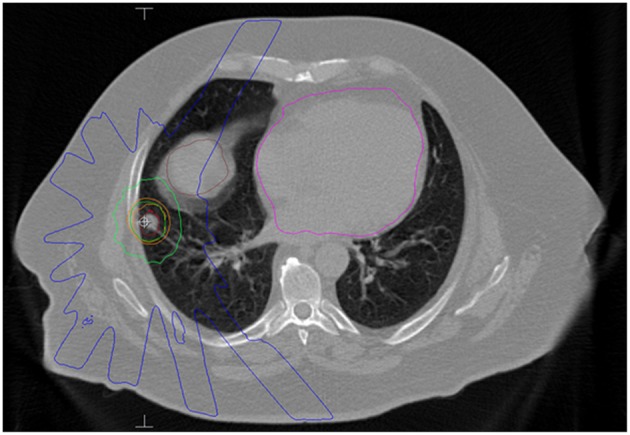
Axial slice of an SBRT plan for a patient with a single lung metastasis from a colonic adenocarcinoma. He received 50 Gy in 5 fractions. The red contour is the internal target volume (ITV) and the orange contour is the planning target volume (PTV). The dark green line is the 50 Gy isodose line. The light green line represents the 25 Gy isodose line and the blue line represents 10 Gy. The brown structure is the liver and the magenta structure is the heart.